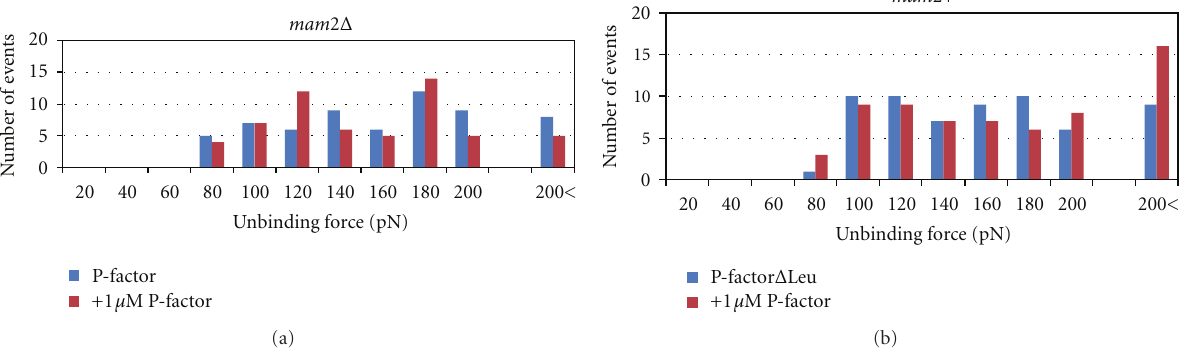
Figure 3: Force histogram of unbinding events with (red columns) or without (blue columns) free 1 μ M P-factor. (a) Unbinding events between AFM tip modified with P-factor and mam2 Δ strain cells. (b) Unbinding events between AFM tip modified with P-factor Δ Leu and mam2+ strain cells.